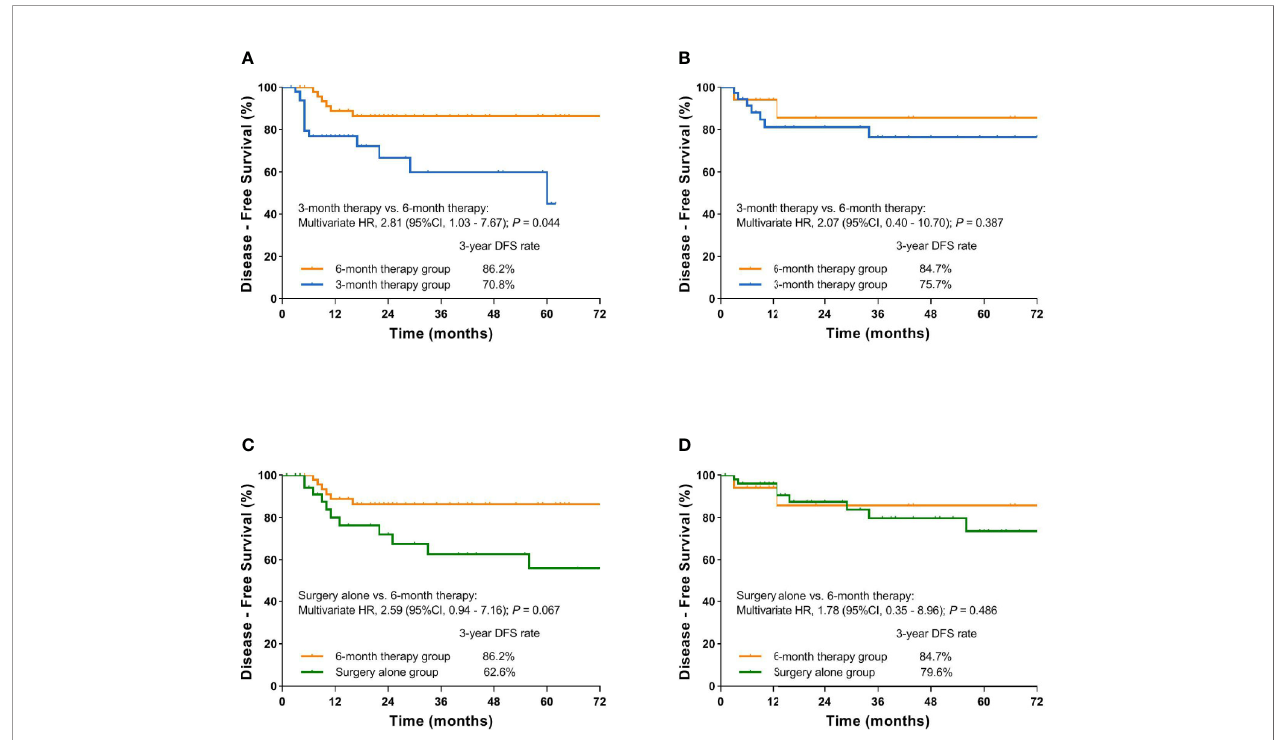
FIGURE 3 | (A) Kaplan-Meier curve of disease-free survival comparing 6-month therapy group and 3-month therapy group for patients with pathologic stage III; (B) Kaplan-Meier curve of disease-free survival comparing 6-month therapy group and 3-month therapy group for patients with high-risk stage II; (C) Kaplan-Meier curve of disease-free survival comparing 6-month therapy group and surgery alone group for patients with pathologic stage III; (D) Kaplan-Meier curve of disease- free survival comparing 6-month therapy group and surgery alone group for patients with high-risk stage II.